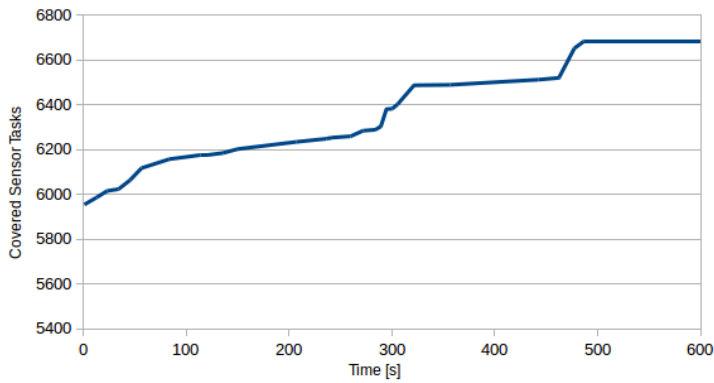
Figure 7. How the coverage improves over time. Base (time 0) is greedy solution: coverage 57%. The time limit has been set to 10 min, but the best solution with coverage of 64% was found after 8.1 min.